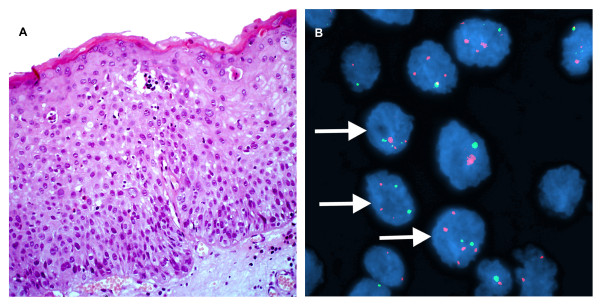
A case of sereve dysplasia of the larynx . A. H&E stain. (×200). B. Interphase FISH displaying a CSP3: hTERC signal pattern is 2:3, 2:5, 3:3, and etc. (×1000).